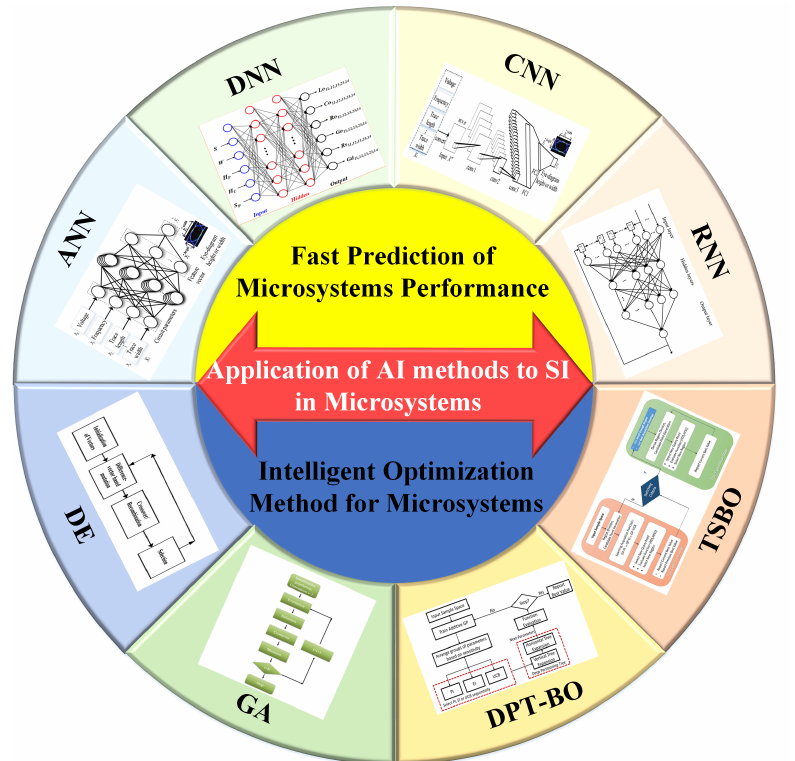
Figure 1. AI methods of SI design in